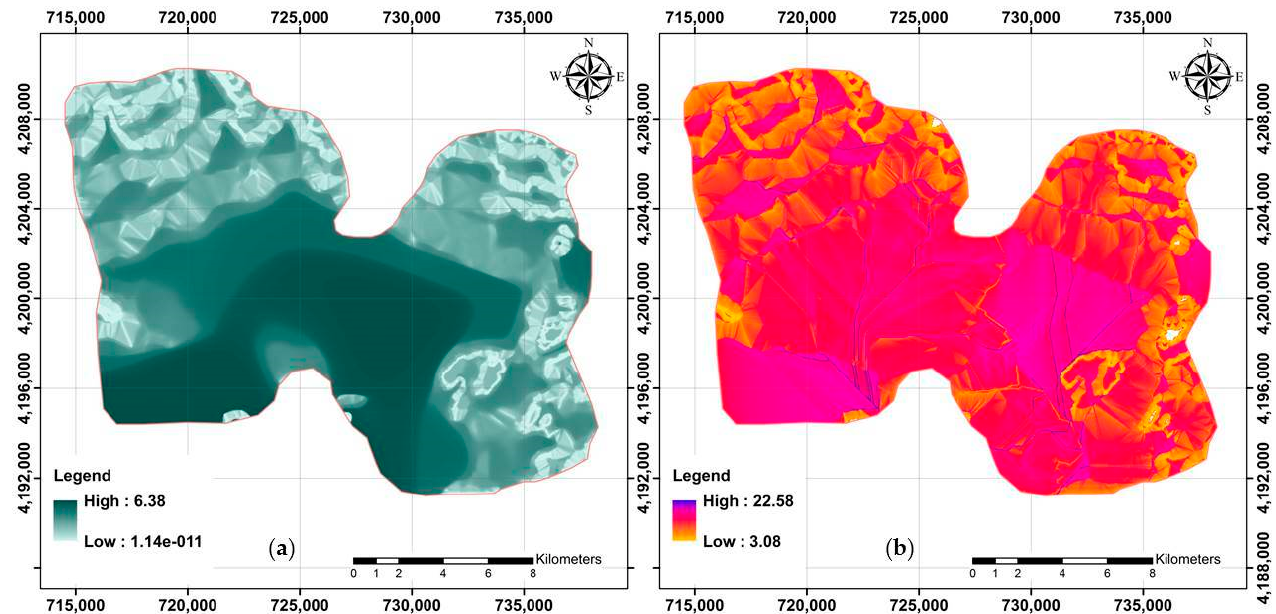
Figure 3. Two examples of terrain-related attributes applied to model across the study area. ( a ) MVF (multi-resolution index of valley bottom flatness) and ( b ) TWI (topographic wetness index).